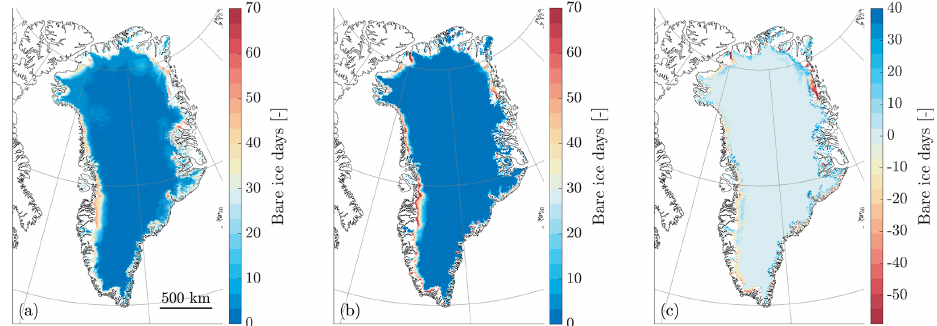
Figure 2. Number of days bare ice is exposed in JJA, averaged over 2000–2021: (a) observed by MODIS at 500m, (b) modeled by MAR at 6.5km, and (c) their difference (MODIS minus MAR) at 6.5km.